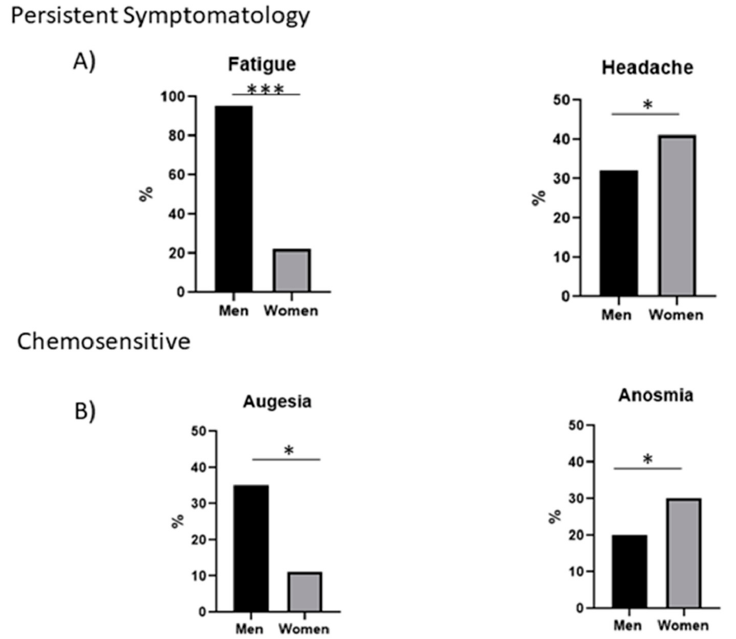
Figure 1. Persistent and chemo-sensitive symptoms post-COVID-19. ( A ) Percentage of men and women who present fatigue and headache. n = 76 (40 men and 36 women). The statistical test used was Student’s t-test. The statistical difference is p < 0.05 *, p < 0.0001 *** ( B ) Percentage of men and women with anosmia and augesia. n = 76 (40 men and 36 women). The statistical test used was Student’s t-test. The statistical difference is p < 0.05 *, p < 0.0001 ***.